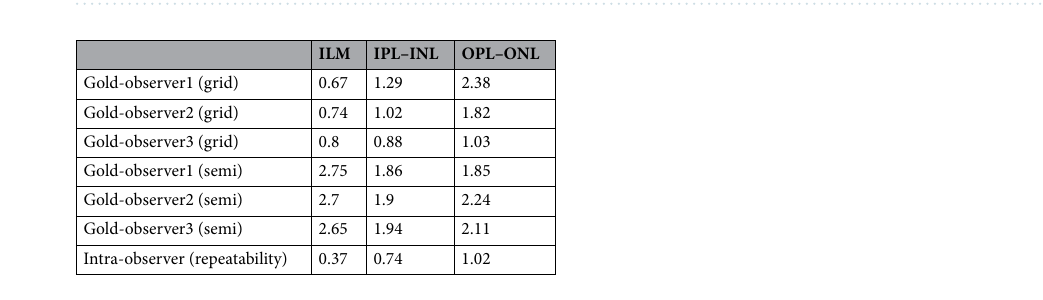
Table 3. Unsigned errors (in pixels) between the gold standard and each observer’s grid-manual and semi- automatic segmentation as well as the intra-observer errors.